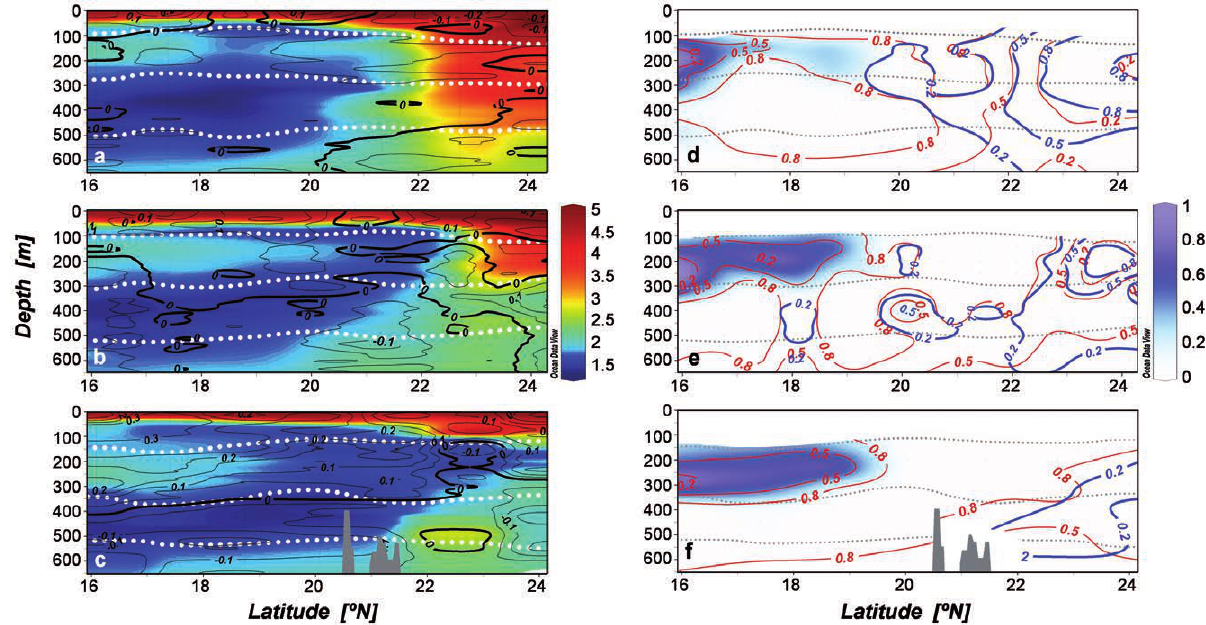
F ig . 6. – Left panels: Distributions of oxygen content ([ml l –1 ], colour-coded according to the right-hand-side colour bar) and meridional velocity ([m s –1 ], black lines, positive northward). Right panels: Contribution of three different water masses along the same sections: SACW (blue colours following the right-hand-side colour bar), SACWcv (red contours) and NACW (blue contours). Three selected isopycnals (26.46, 26.85 and 27.1) are indicated with white (grey) dotted lines in the left (right) panel. The top, central and bottom panels correspond to the along-slope sections located offshore and over the 2000 and 1000 m isobaths, respectively (Fig.